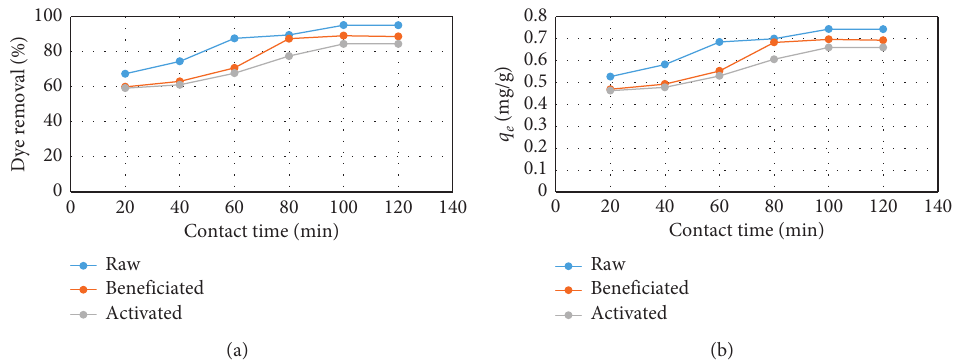
Figure 8: (a) Effect of contact time on MB dye removal efficiency by raw, beneficiated, and activated adsorbents. (b) Effect of contact time on MB dye adsorption capacity by raw, beneficiated, and activated adsorbents.